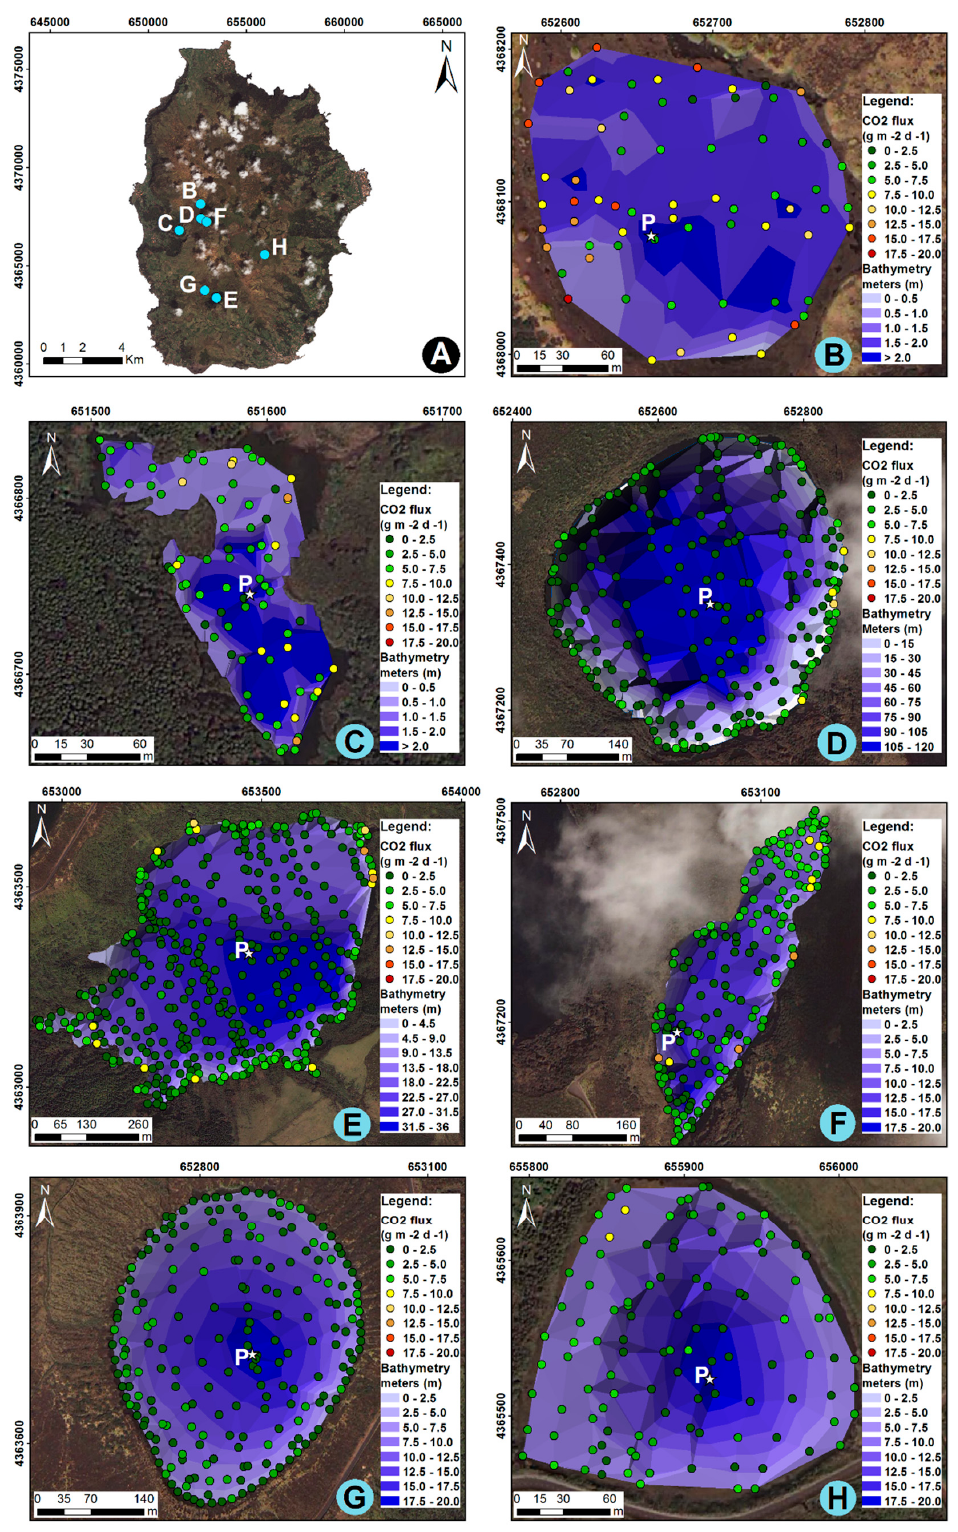
Figure 2. Location of the studied areas (UTM–WGS1984, zone 25S): ( A ) framework of Flores Island with the locations of the studied lakes; ( B – H ) bathymetry and CO 2 flux sampling points measured in the first surveys, respectively, for the following lakes: ( B ) Branca; ( C ) Patos; ( D ) Negra; ( E ) Funda; ( F ) Comprida; ( G ) Rasa; and ( H ) Lomba. The sampling locations of the geochemical vertical profiles (P) are also shown for each lake.